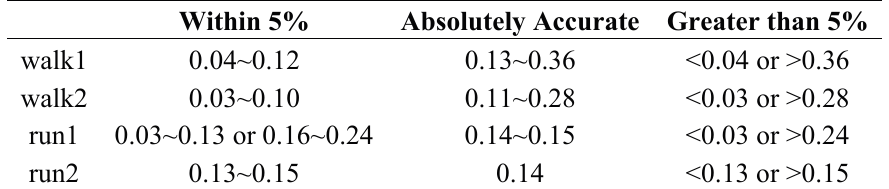
Table 1. Gait recognition based on simple parameters’